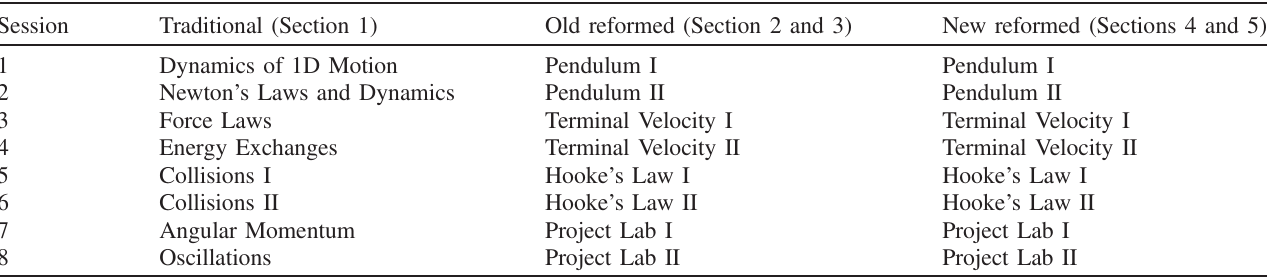
TABLE II. Topics of lab activities for each session for each lab type. The project labs were sessions where students had the freedom to explore a question building off one of the previously studied topics. The old reformed labs had an extra lab session studying “ collisions ” between sessions six and seven that the new reformed labs did not. This session was not codable and was omitted from all analysis, so the session numbers for the old reformed labs are modified to match those in the new reformed